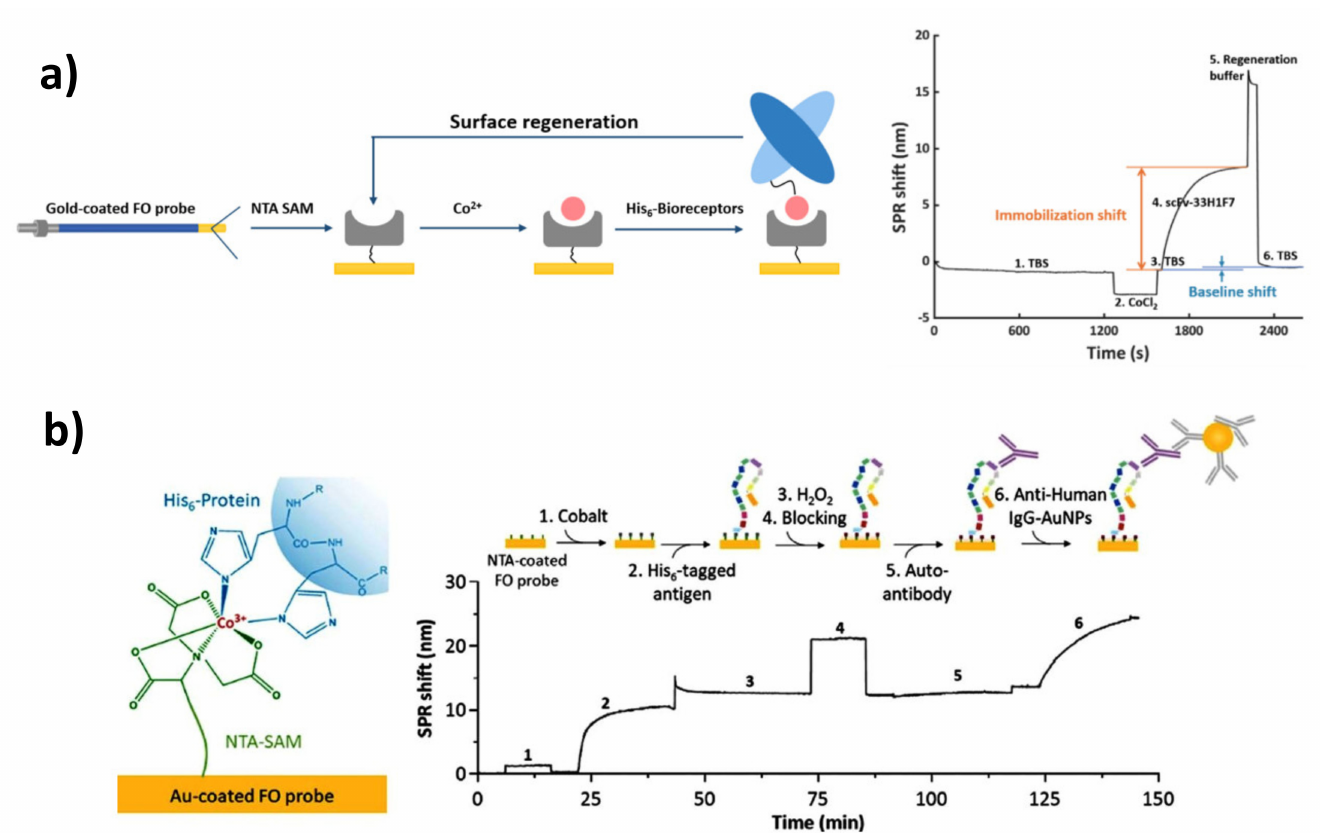
Figure 9. The application of cobalt ion-nitrilotriacetic acid complexes in SPR substrates for the immobilization of recombinant proteins. ( a ) Easily regenerable immobilization with a Co 2+ ion, ( b ) robust chelation with a Co 3+ ion. Adapted with permission from Qu et al. [187] (under the terms and conditions of the Creative Commons CC BY License) and Horta et al. [186] (Copyright © (2020) American Chemical